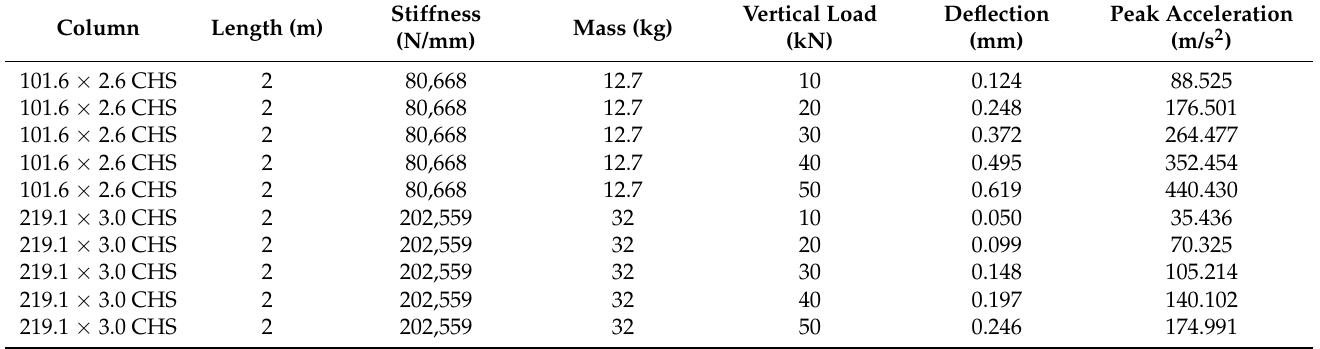
Table 1. Response of the structure subjected to suddenly released load.